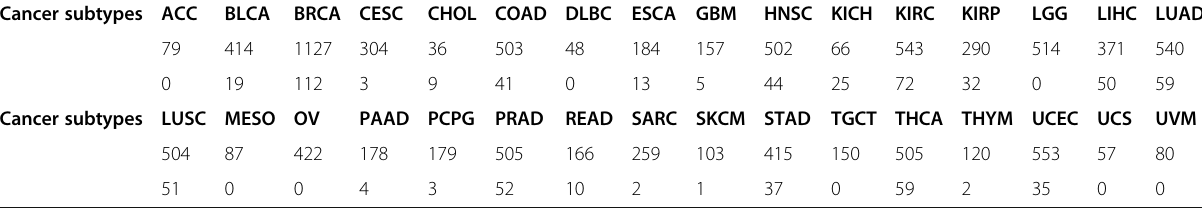
Table 1 Numbers of primary tumor and normal tissue samples Cancer subtypes